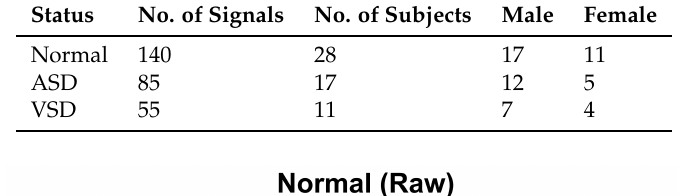
Table 2. Description of PCG dataset.